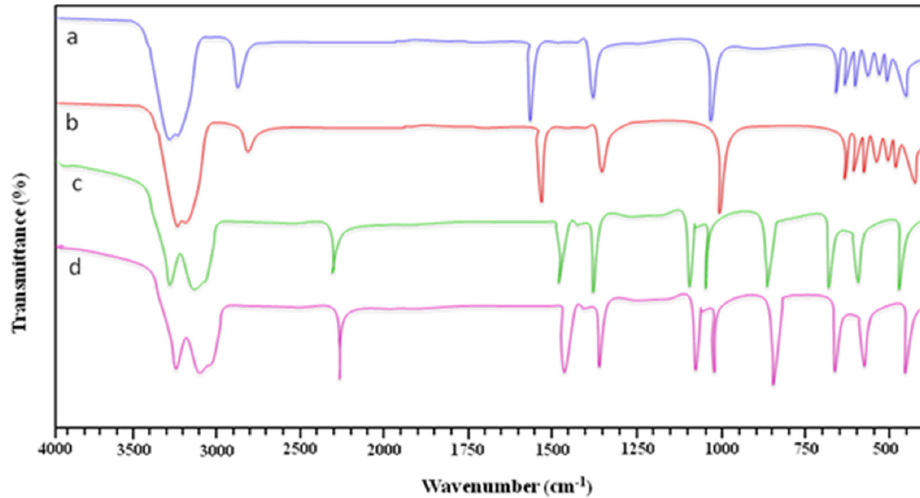
Figure 4. FT-IR spectra ( a ) TSADE, ( b ) TSDESNPs, ( c ) TSFPE, ( d ) TSFESNPs.